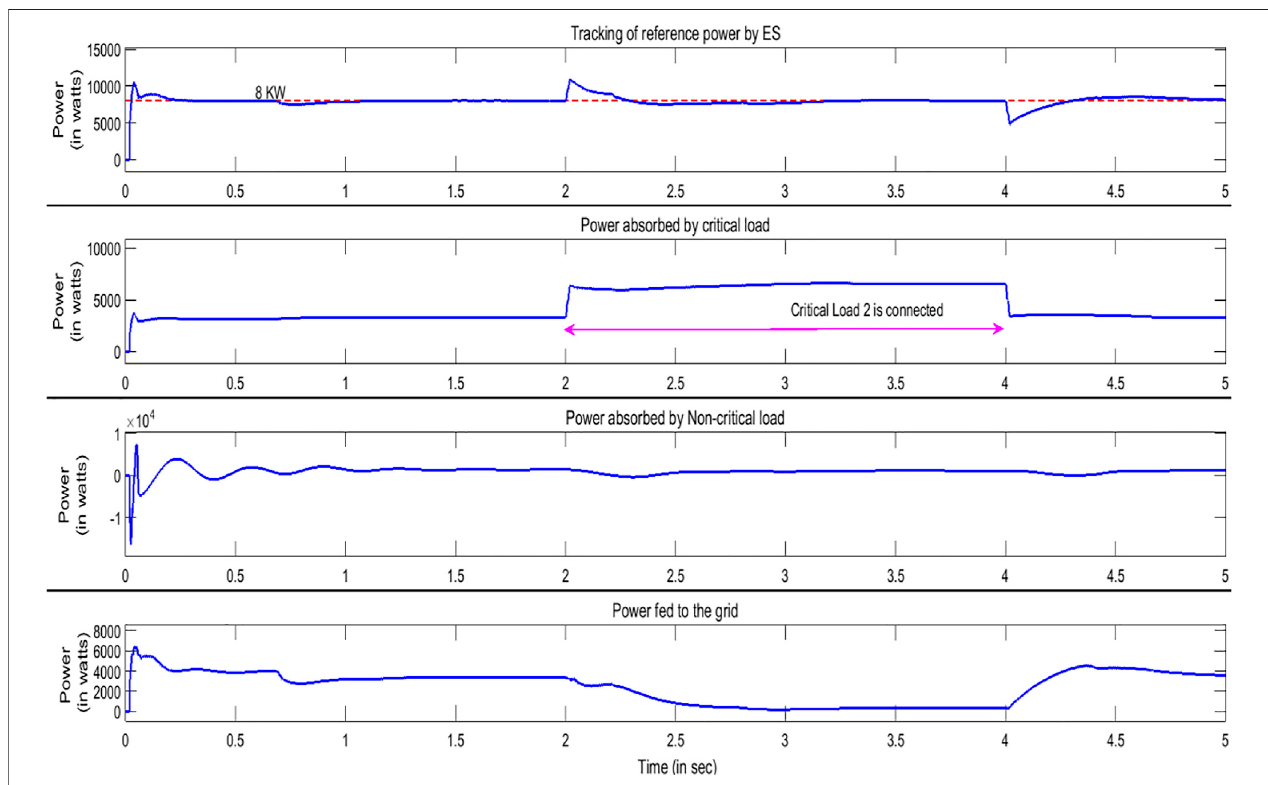
FIGURE 10 | Performance for change in critical load and P ref = 8